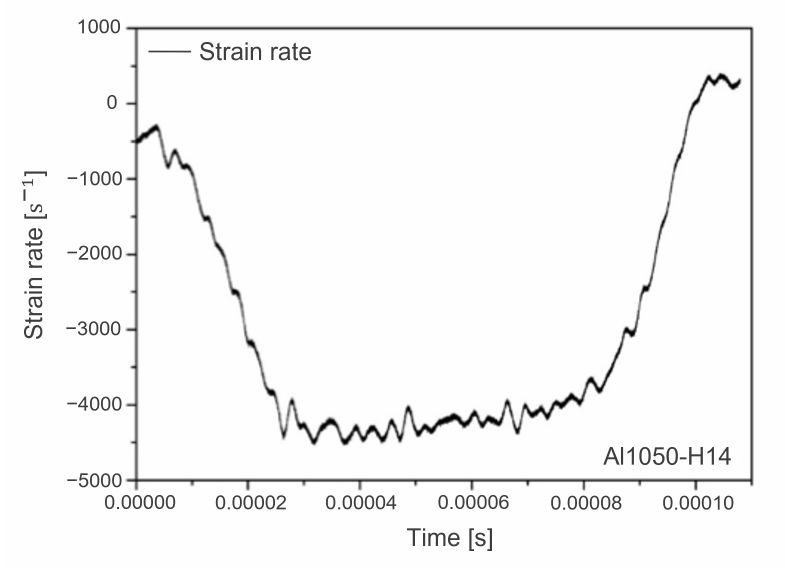
Figure 26. Measured strain rates with aluminum 1050-H14.